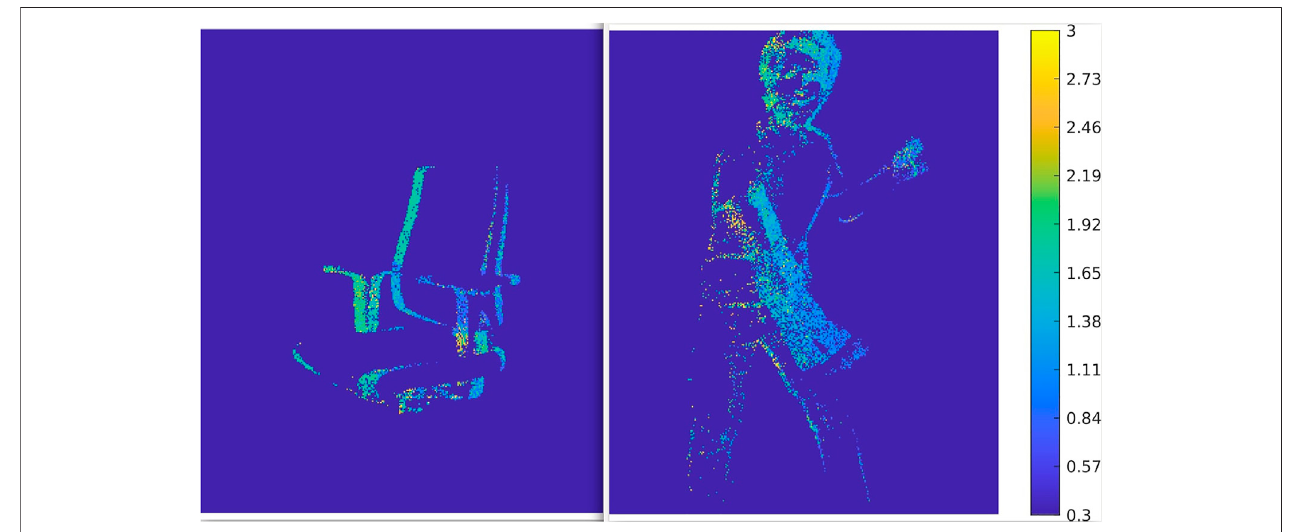
FIGURE 4 | Depth maps of reconstructed scenes from synchronized event-streams of two ATIS. The color bar on the side states which color represents which distance. It can be seen that the areas closest to the camera like the left armrest or the left arm, are of a darker blue as these object ’ s distance to the sensor about 0.3 – 1.0 m. Respectively, areas further away, like the right edge of the back rest or the head, are colored green, representing a distance of ca. 1.6 – 2.1 m.